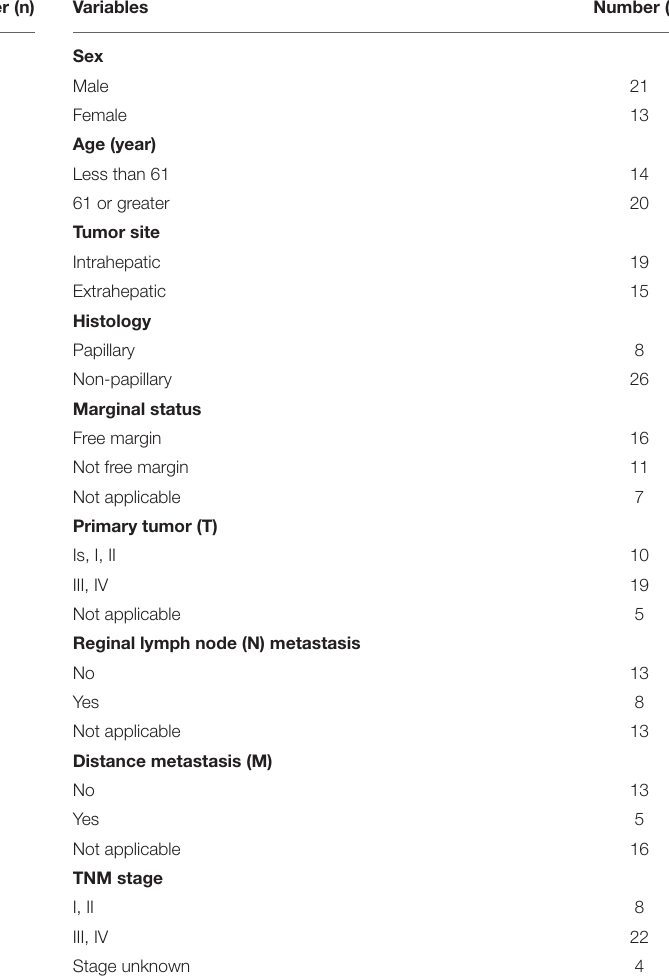
TABLE 2 | The characteristics of all patients with CCA whose serum was studied by metabolomics